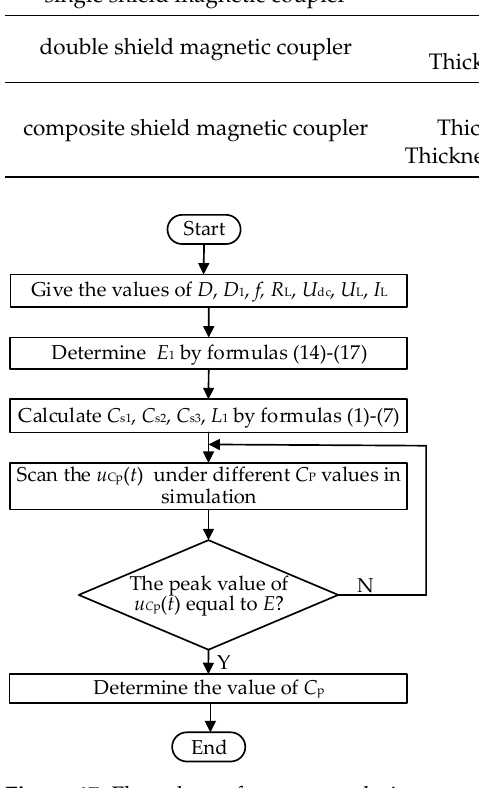
Figure 17. Flow chart of parameter design.